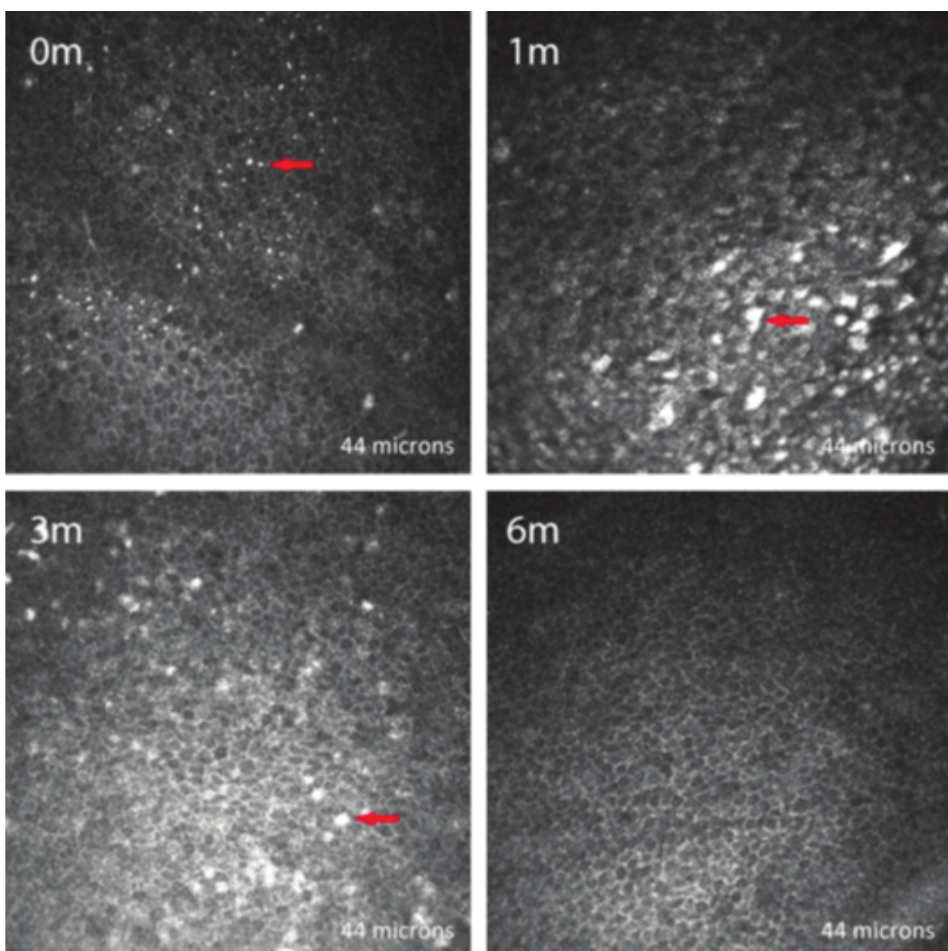
Figure 1. In vivo confocal microscopic images of the epithelium in a representative patient, taken at the same level at each visit. The epithelium appears normal preoperatively (0 m) which showed minimal disorganization at one month (1 m) and three months (3 m) but normalization at six months (6 m). Microdot cells (arrows) were hyperreflective and showed an increase in size at one month and gradually reverted to original state over